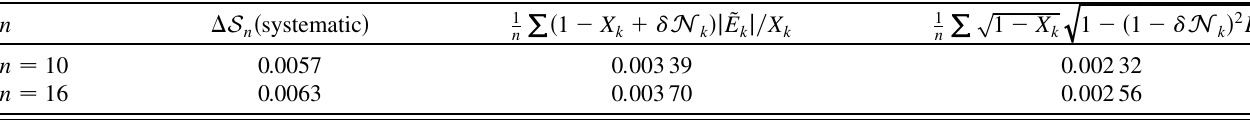
TABLE II. Size of error factors contributing to (cid:4) S n ð systematic Þ (Fig. 5 data) with 1-km fiber. n 1